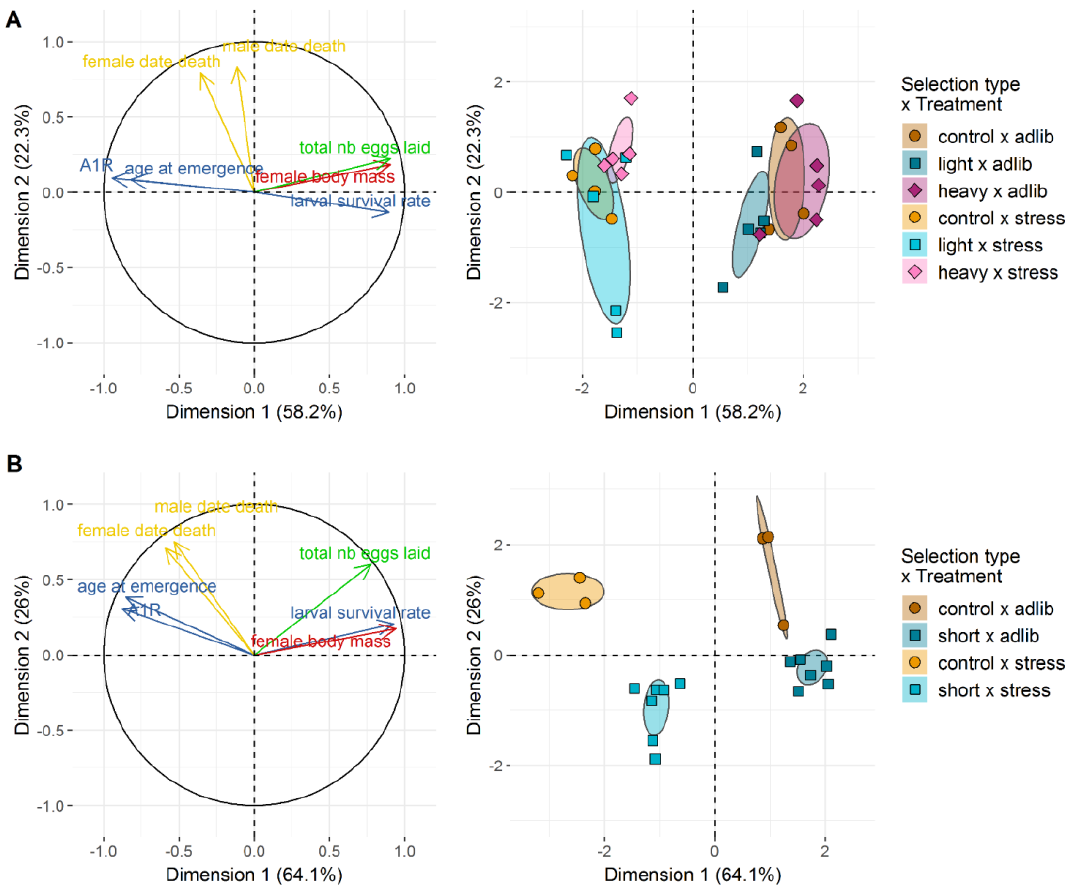
Figure 5: Organismal-level phenotypic responses to selection and diet. (A) right: Projection of phenotypic traits into the first two dimensions of the Multiple Factor Analysis (MFA) on G9 individuals of the female body mass selection regime. A1R stands for age at first reproduction. (A) left: Projection of replicate experimental lines from selection on female body mass into the first two dimensions of the same MFA. Diet is a major factor separating global phenotypes while selection regime is a more